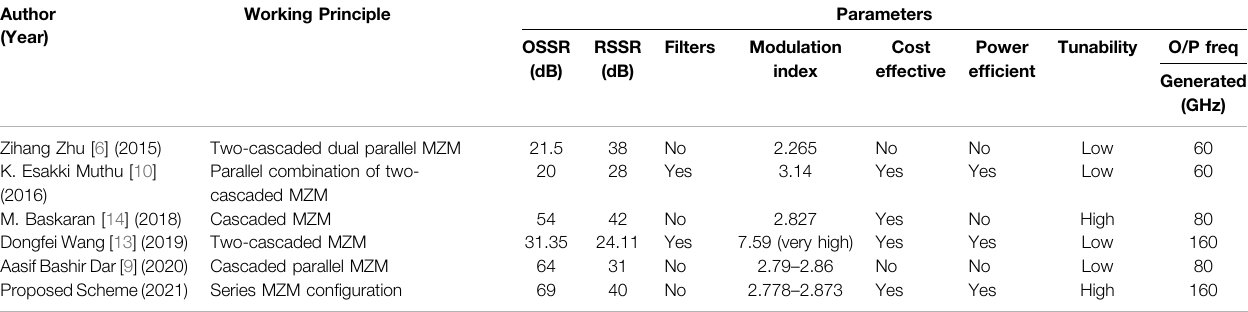
TABLE 1 | Literature review of frequency 16-tupled MM wave generation based on different parameters. Author